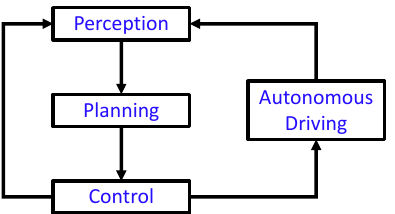
Figure 1. The cycle of autonomous vehicle core